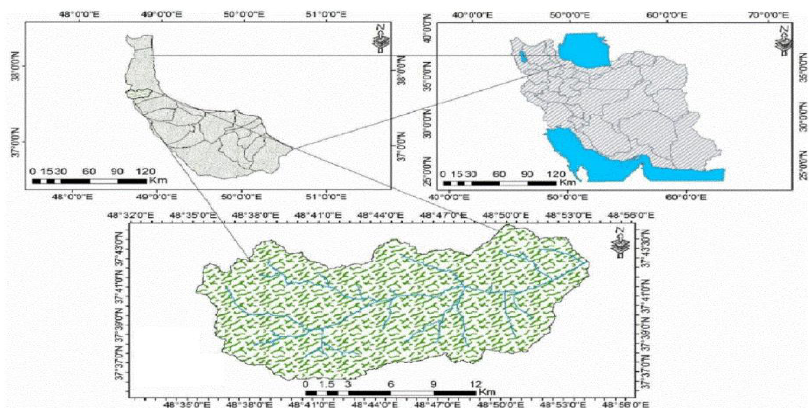
Fig.1. Location of studied area in the related province and country (Iran) Table1. Physiographic characterizations of studied